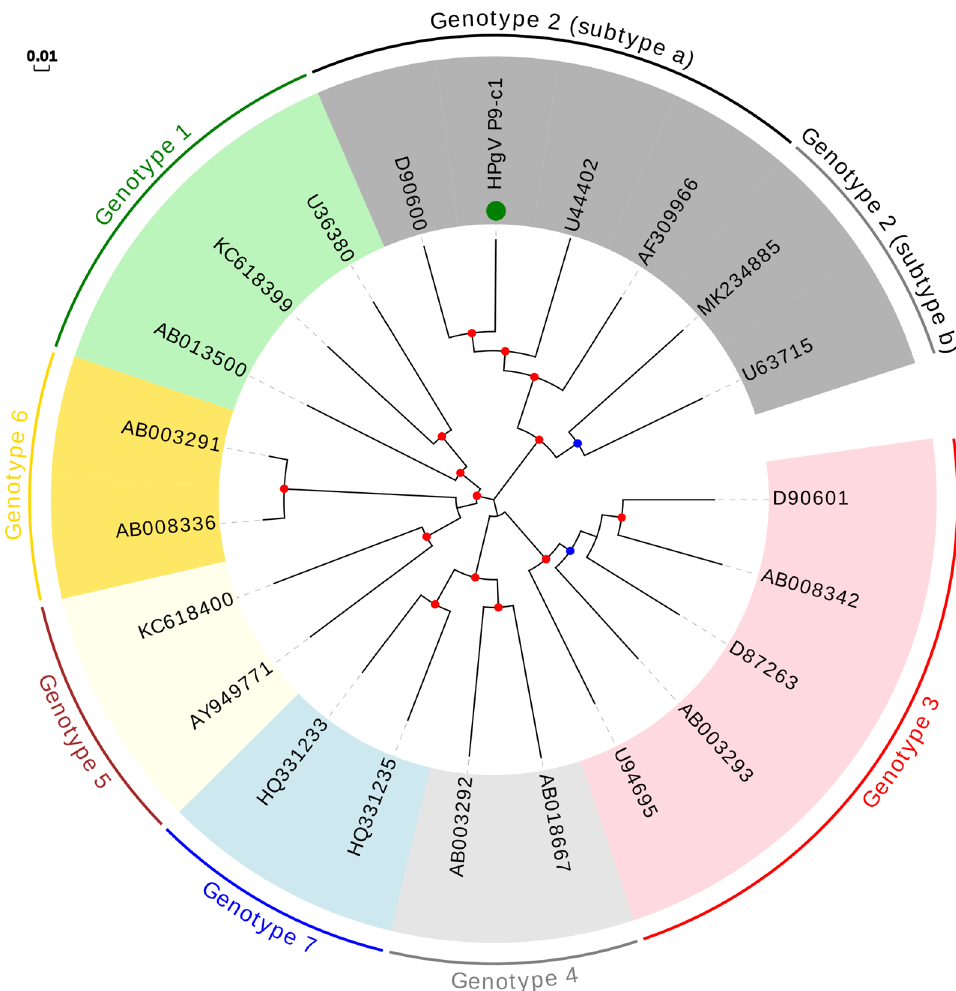
Figure 3. Phylogenetic tree based on the full coding sequence (i.e. the polyprotein) including representative isolates of the seven known HPgV genotypes. The sequence described in this study is indicated with a green circle. For genotype 2, distinct members from 2a and 2b subtypes are shown. Bootstrap values ranging 0.75–0.9 and 0.9–1.0 are indicated with blue and red circles, respectively. The scale bar indicates evolutionary distance in nucleotide substitutions per